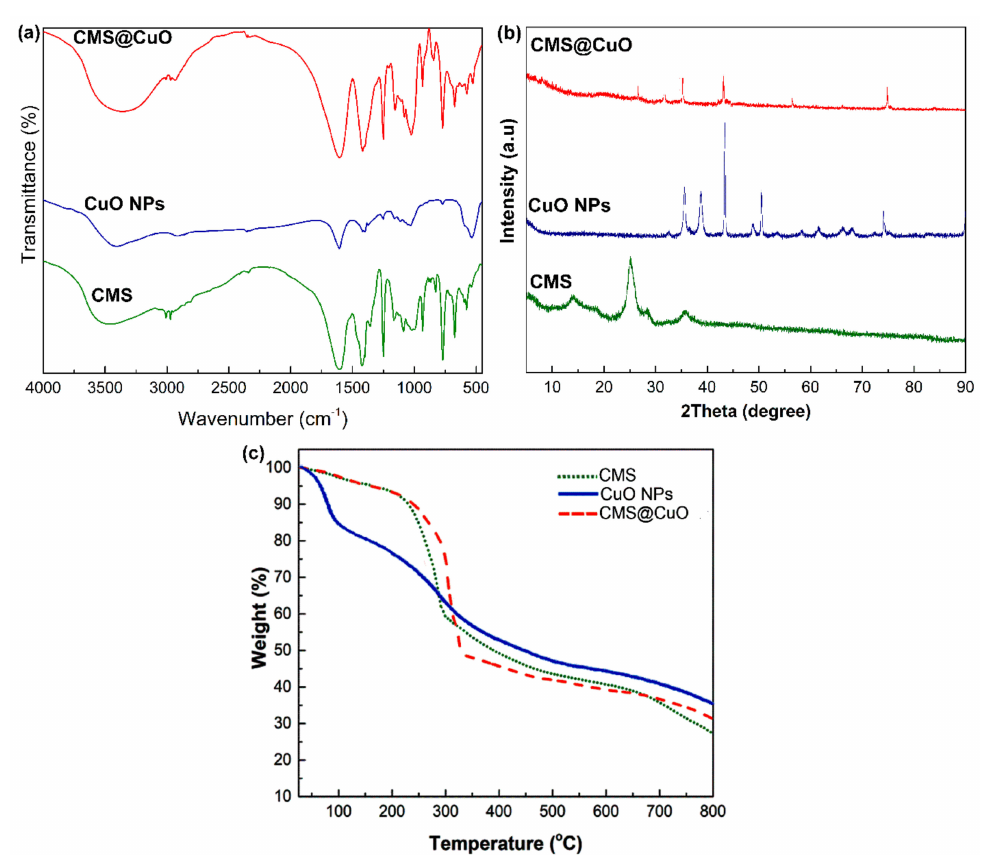
Figure 2. Fourier transform infrared (FTIR) ( a ), X-ray diffraction (XRD) ( b ), and thermogravimetric analysis (TGA) ( c ) of CMS, CuO nanoparticles, and the CMS@2%CuO nanocomposite